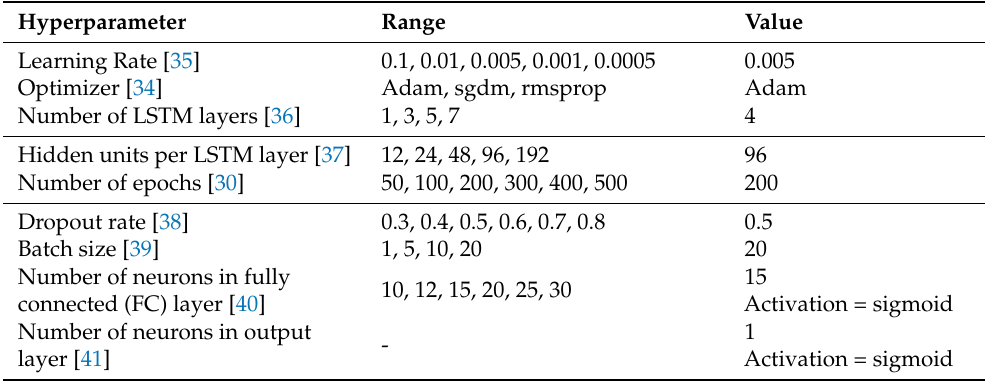
Table 3. Parameter settings for the SMOTE-based deep LSTM